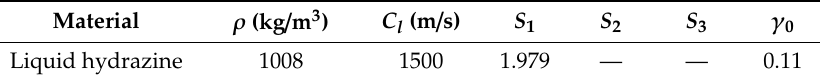
Table 4. Materials parameters of liquid hydrazine.